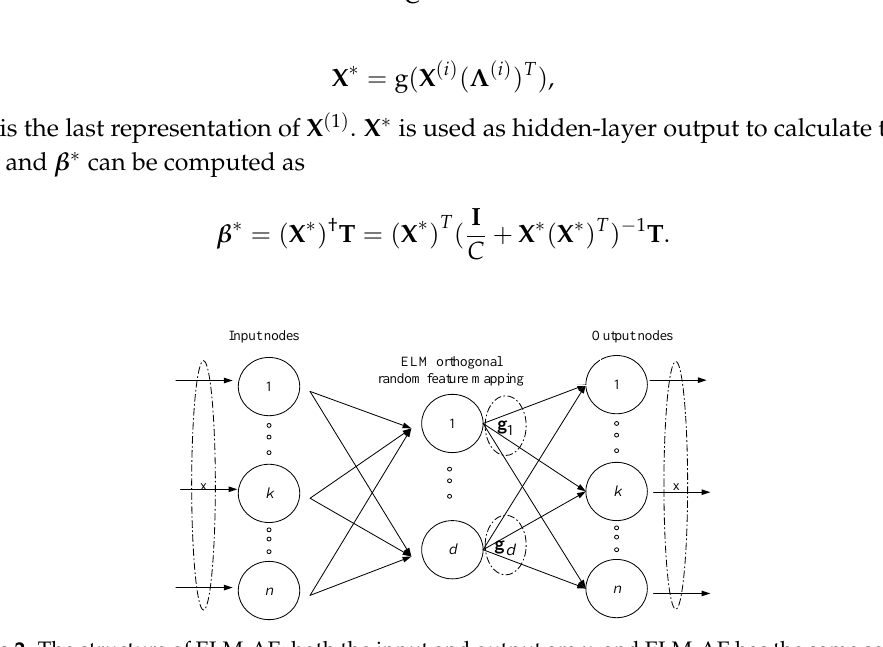
Figure 2. The structure of ELM-AE: both the input and output are x , and ELM-AE has the same solution as the original ELM. g d is the d -th hidden node for input x .